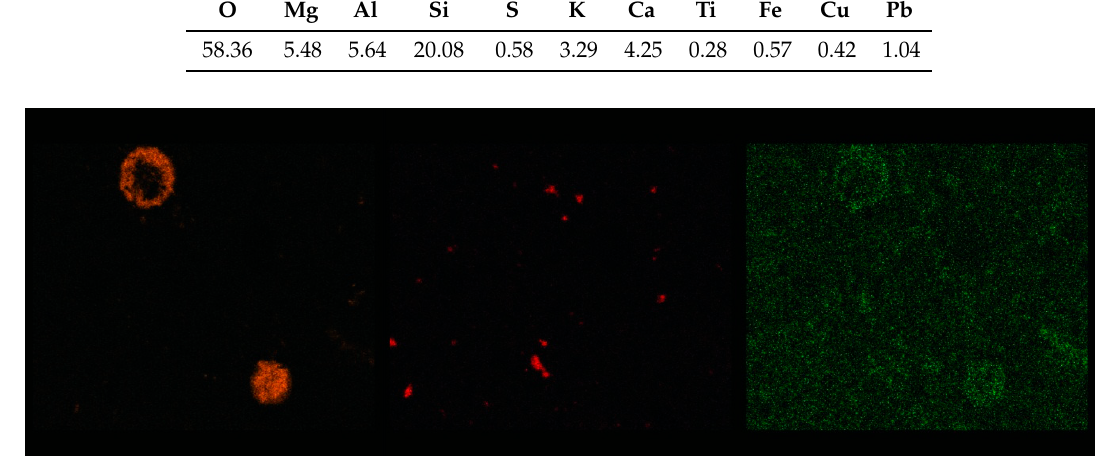
Figure 7. EDS mapping of Ba, Cu, and Pb in the matrix.